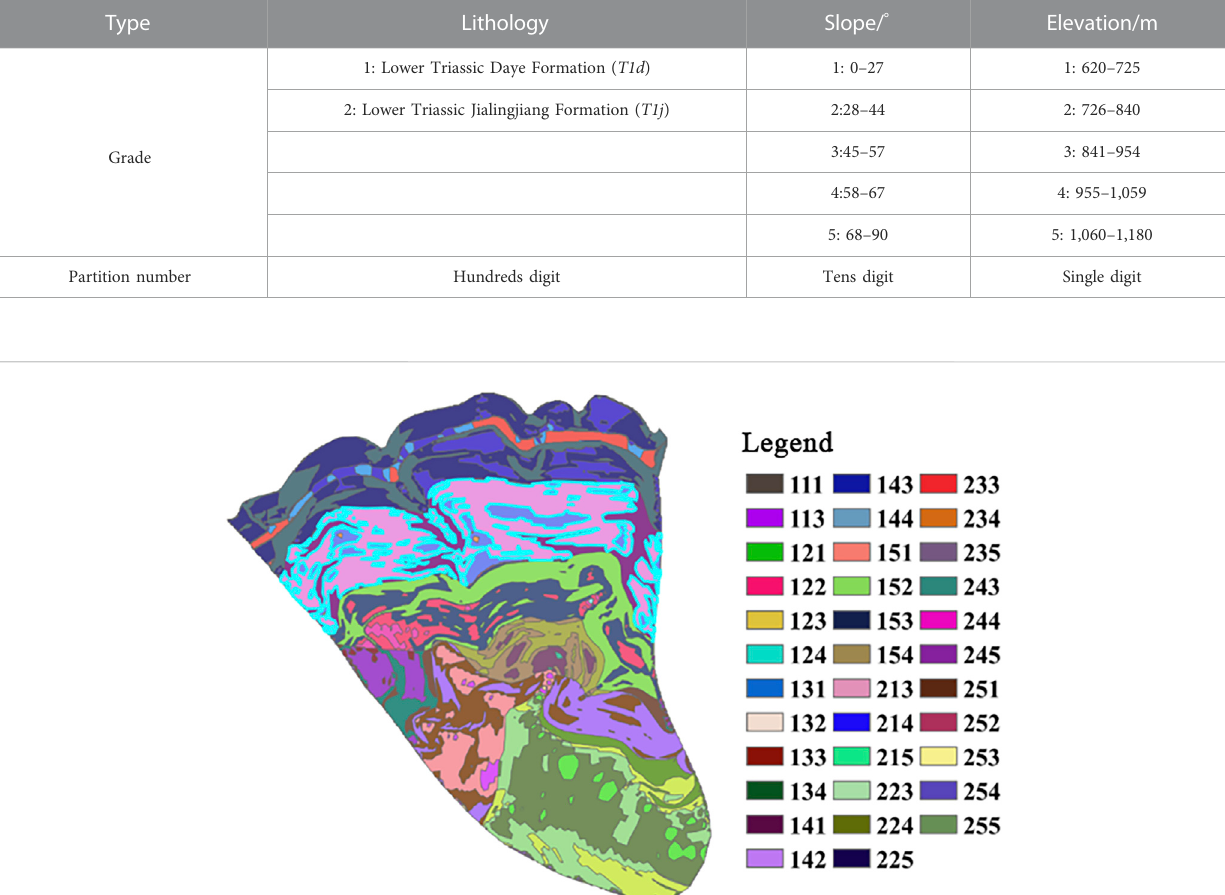
TABLE 1 Bank slope geological zoning basis.